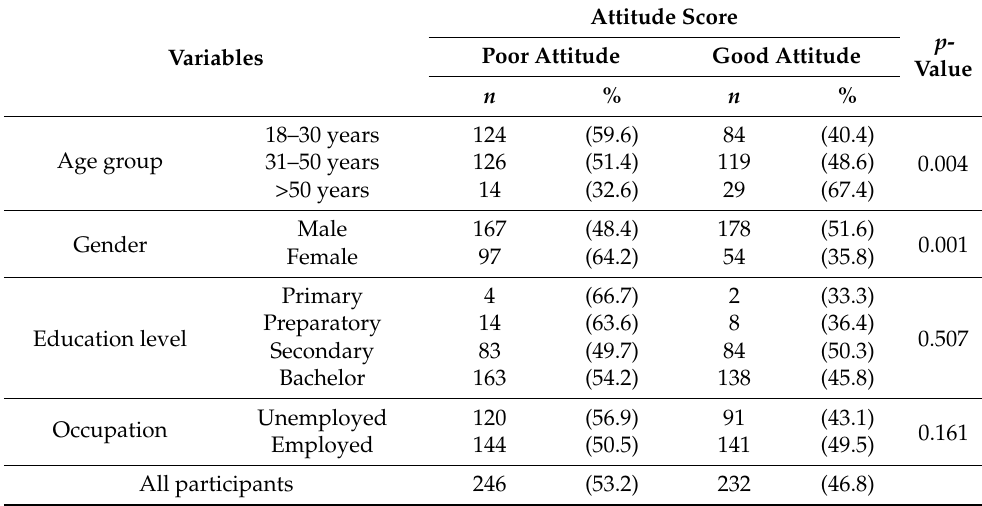
Table 5. Association between demographics and participants’ attitude toward vitiligo.